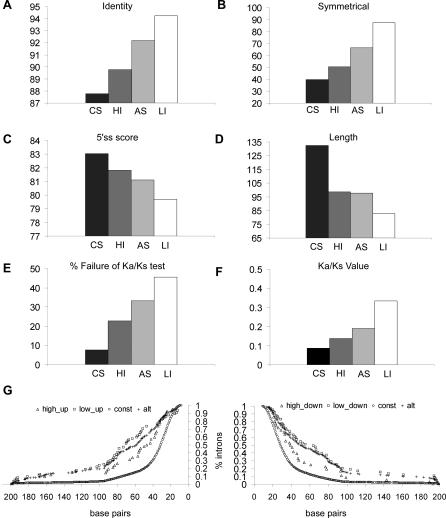
High Inclusion (HI) and Low Inclusion (LI) Alternative Cassette Exons Exhibit Different CharacteristicsThe conserved alternative cassette exons were tested for their inclusion level. Conserved alternative cassette exons with LI and HI were compared with conserved constitutively spliced and all alternative cassette exons: (A) exon conservation level; (B) percentage of symmetrical exons; (C) 5′ss score; (D) average length; (E) percent of exons that failed the Ka/Ks likelihood ratio test; (F) Ka/Ks value; and (G) conservation of the flanking intronic sequences. Median conservation level at each base position was calculated for the 200 base pairs upstream (left) and downstream (right) for the CS (circle), HI (triangle), AS (plus), and LI (square) exons.